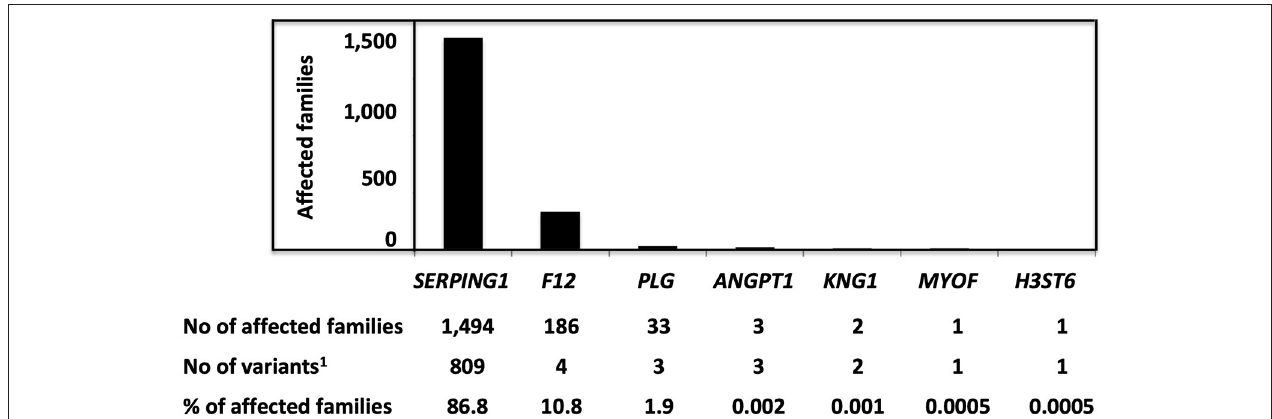
FIGURE 2 | The distribution of variants responsible for HAE and characterized as pathogenic/likely pathogenic, with a number of affected families. Pathogenic/likely pathogenic variants have been characterized in agreement with the American College of Medical Genetics (ACMG) criteria or as declared by authors in the observations. 1 Variants were characterized as pathogenic/likely